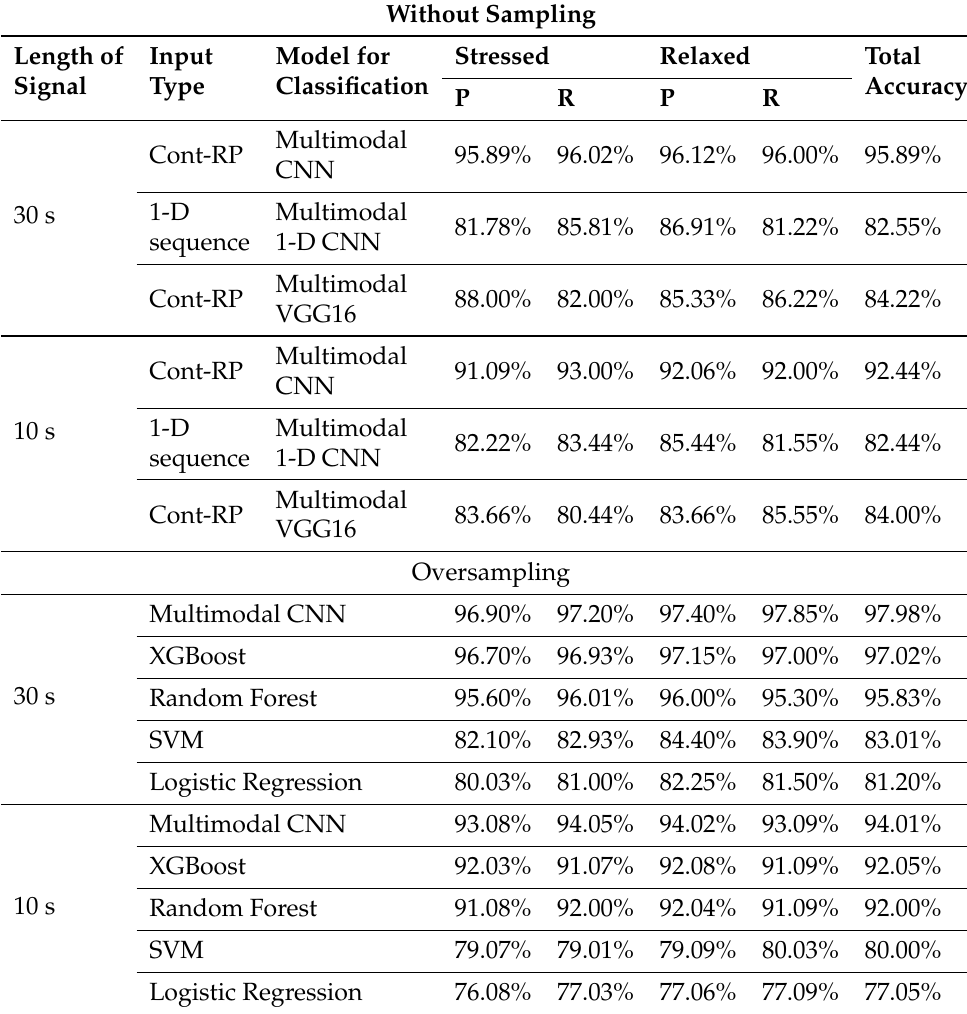
Table 8. Comparison between the results of over-sampling and without-sampling using original